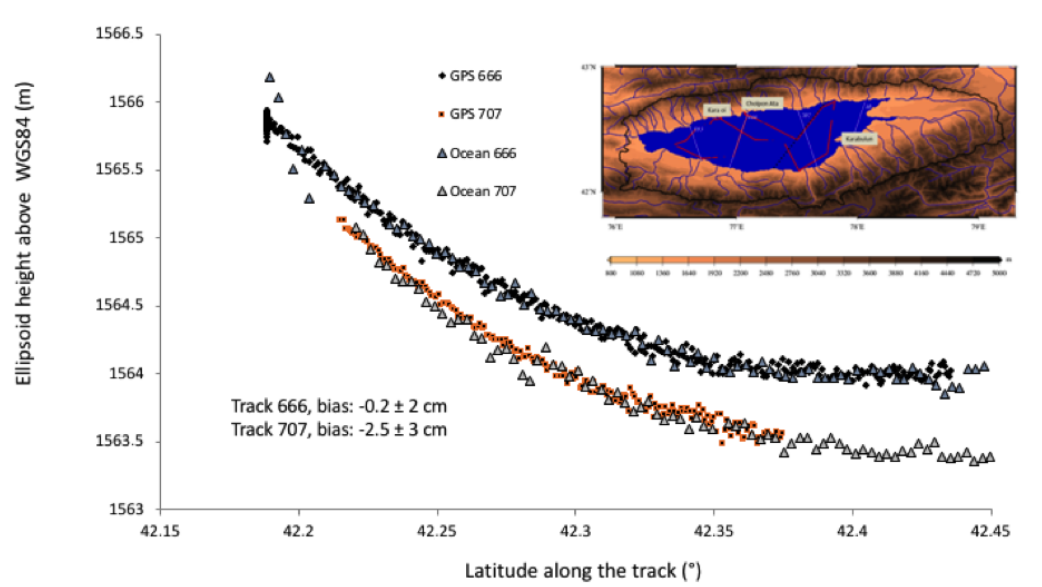
Figure 27. Height of the lake surface above the reference ellipsoid as measured by Sentinel-3A with the Ocean retracker for cycle 9 (Oct. 2016), for the two tracks (666 and 707) and with the GNSS on the boat. (Inset shows the position of the tracks over the lake and the challenges of the high surrounding